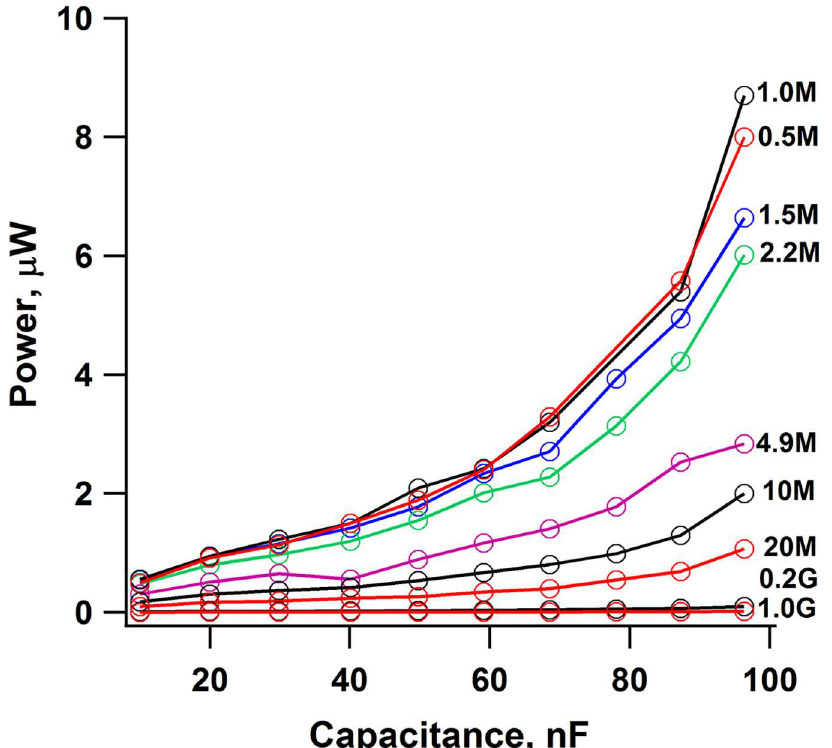
Fig 4. Power generation by a stack of 10 PVDF elements attached to base of 48 cm cattail-inspired model, flexed at 1.3 Hz by a gated air stream (11 knots). Individual elementsconnectedin parallelto increaseC step-wise. Approximate ten-fold increasein power with ten-fold increasein C. For R L = 1 M Ω , Fc = 16.7, 2.3 and 1.7 Hz at 1, 7 and 10 elementsconnectedin